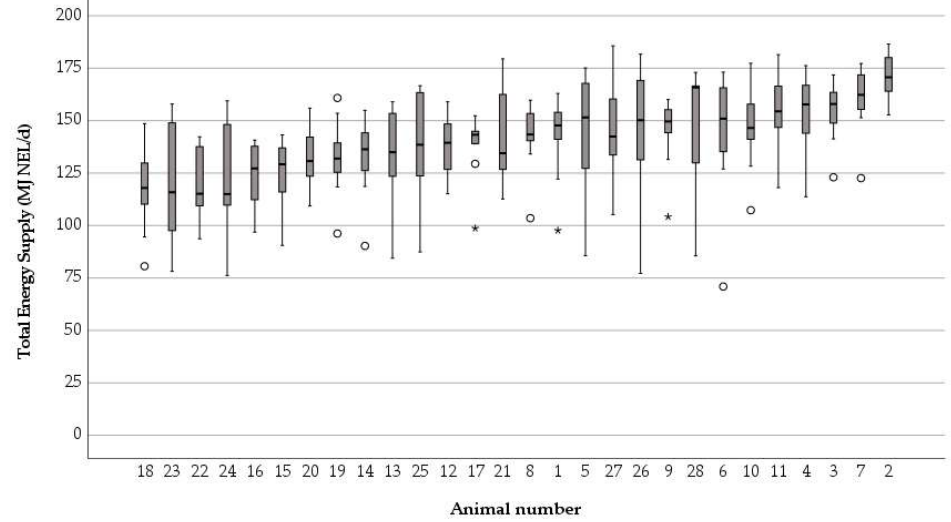
Figure 2. Total energy supply (MJ NEL/d) calculated between weeks 2 and 15 postpartum (p.p.). In each subfigure, the boxplots respectively highlight the median, upper, and lower quartiles of each week. Box whiskers that extended to the most extreme nonoutlier data points were considered as outliers if they lay more than 1.5 times the interquartile range from the edge of the box. Small circles = outliers (1.5 × interquartile range (IQR)); asterisks = extreme values (3 × IQR). BCS decreased with a linear ( p = 0.025; η 2 = 0.23) and quadratic ( p = 0.005; η 2 = 0.33) trend from a mean value of 3.1 BCS points in week 2 to 2.84 in week 9. Thereafter, BCS increased up to 2.9 BCS points in the 15 th week of lactation (Figure 3). BCS changes between two weeks are shown in Figure 4. Mean individual cow BCS during the trial period ranged between 2.4 ± 0.2 and 3.6 ± 0.4 and the CV varied between 0.00 and 0.15 (Figure